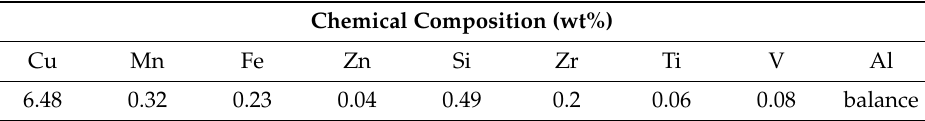
Table 1. Chemical composition of 2219 aluminum alloy.